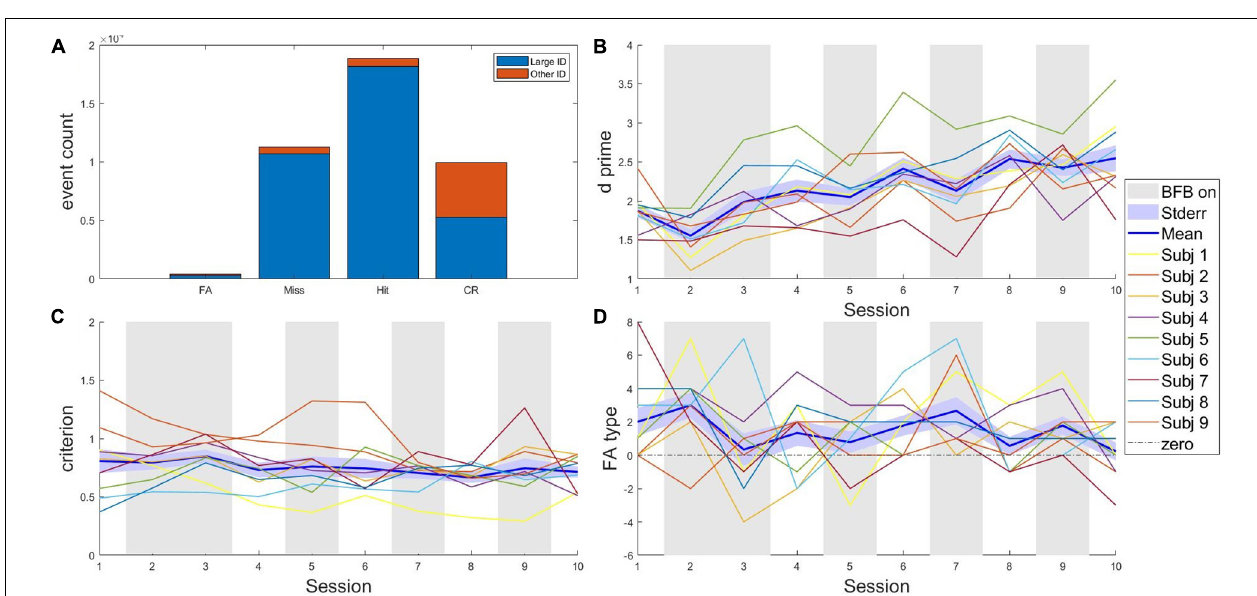
FIGURE 2 | Stability of arousal and engagement during the course of the training. Changes across the whole training in: (A) self-reported challenge (1 = very low to 7 = very high); (B) mean engagement (1 = very low to 7 = very high); (C) HR change, in BMP, from the 30 s pre-test baseline (the dashed line represents a null change); (D) Difference between the self-reported estimation of biofeedback control score after the VR task and the real score (range 0–100%; plotted value = real score—reported score). Stderr, standard error of the mean; BFB ON, Sessions in which online biofeedback was presented to the participants.